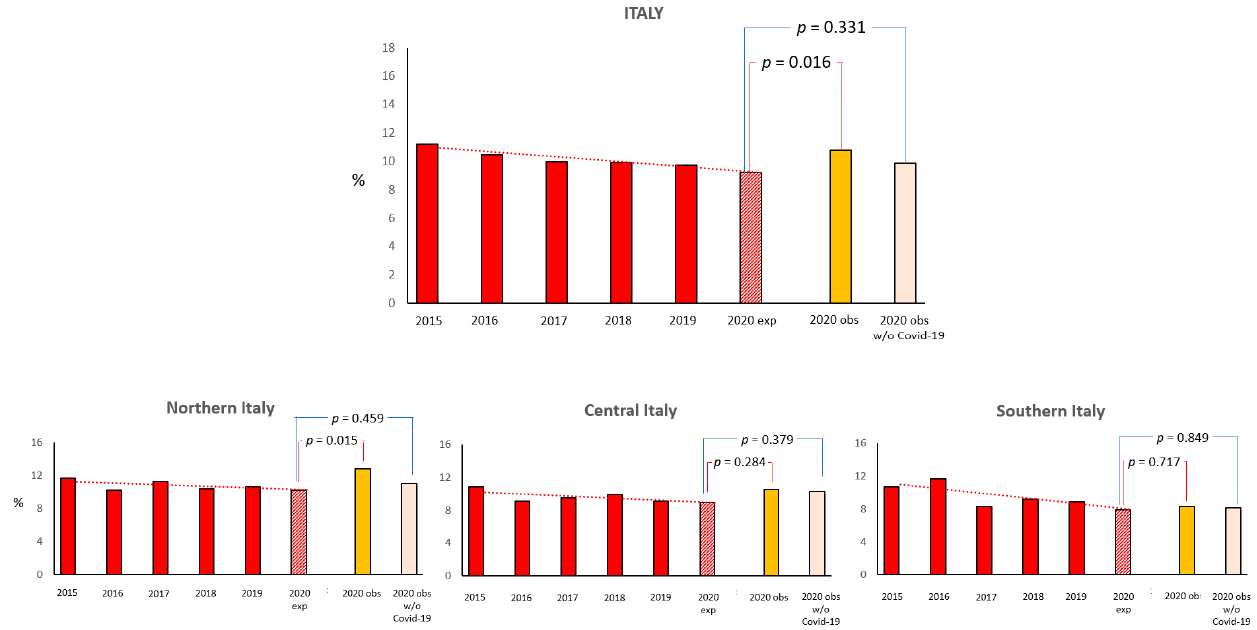
Figure 2. Expected (exp.) and observed (obs.) mortality rate at 30 days (in the overall STEMI population and excluding those with COVID-19 infection) during the 2020 national outbreak and over the equivalent periods in the previous 5 years in Italy and by geographic regions.